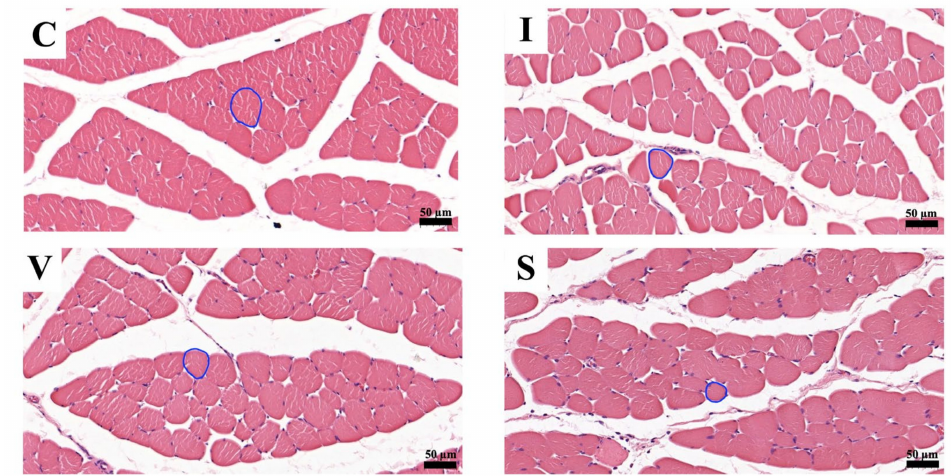
Figure 3. Transverse sections of the quadriceps muscle on Day 15, stained with hematoxylin and eosin at magnification × 200. ( C ) Control group; ( I ) Cast immobilization group; ( V ) Velcro immobilization group; ( S ) Spiral wire immobilization group. The circular line is an example of a round-shaped muscle fiber used for the measurements.